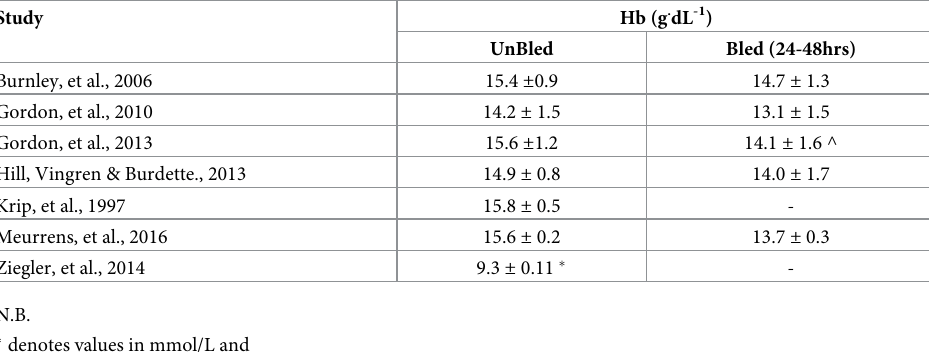
Table 5. Hb pre and post donation (Unbled and bled) values over various time frames, with the Krip, et al. [32] and Ziegler, et al. [34] studies not reporting post donation values.